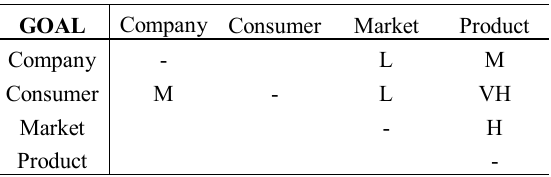
Table2. Pairwise comparisons of criteria with respect to the goal.